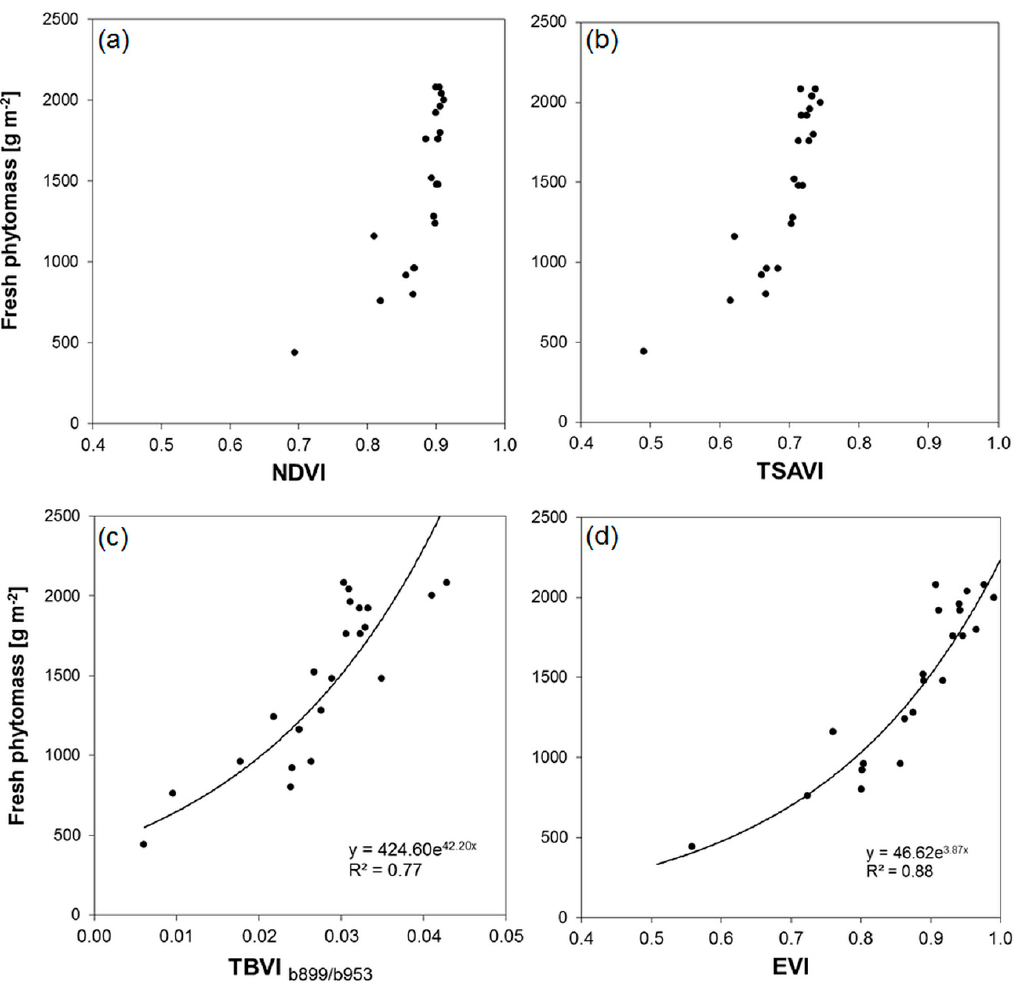
Figure 16. Relationships obtained between ( a ) NDVI; ( b ) TSAVI; ( c ) TBVI b899/b953 ; and ( d ) EVI constructed from VIS bands in combination with NIR band b 899 (except TBVI b899/b953 ) and fresh phytomass of lucerne at the 22 permanent observation sites.